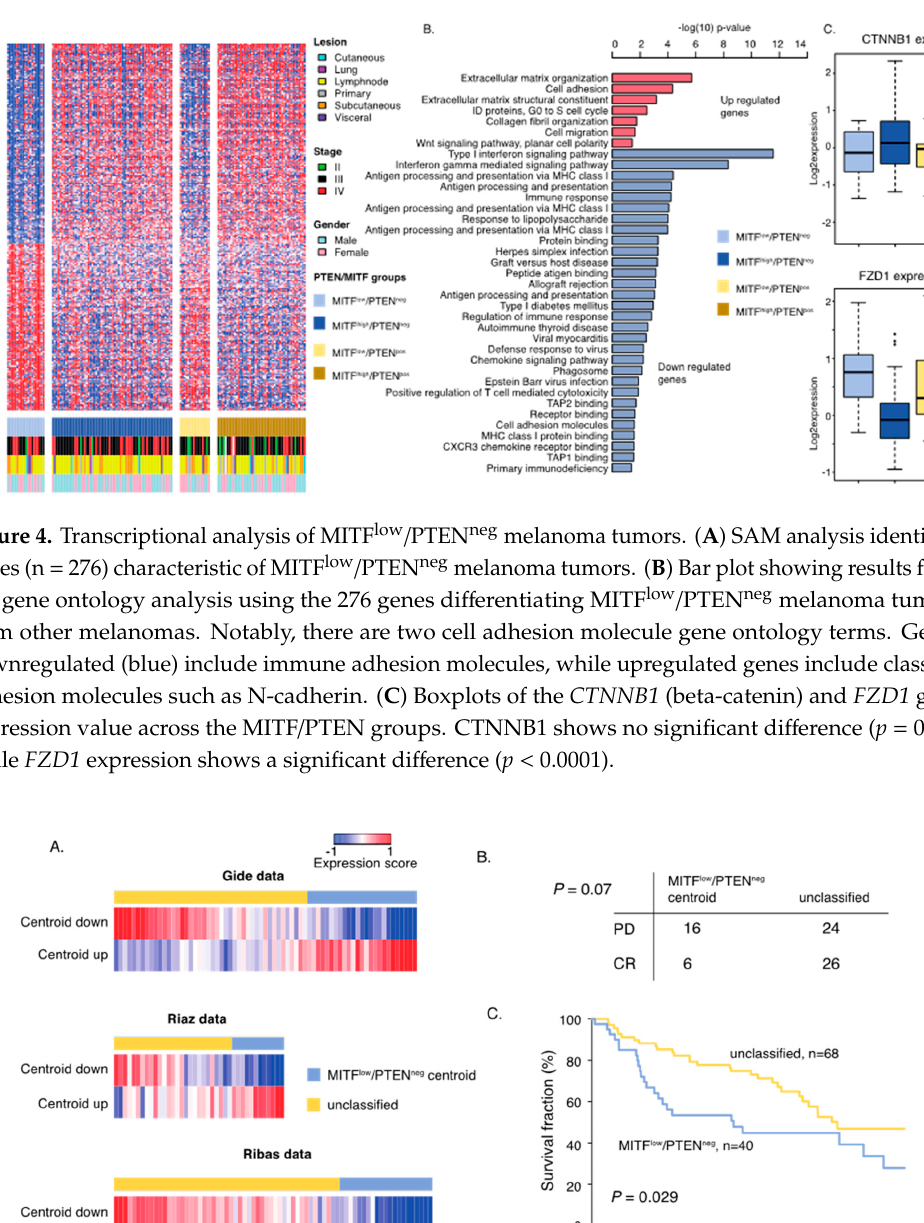
Figure 3. Molecular characterization of MITF/PTEN groups. ( A ) Mutational pattern of representative genes of the MAPK and PI3K pathways in MITF/PTEN groups. In MITF low /PTEN neg , two harbored PTEN mutation, three cases had PIK3CA mutation, and one had PIK3R1 mutation. In the MITF high /PTEN neg group, ten had PTEN mutation and one had PIK3CA mutation. The two other group had one PTEN mutated case each. ( B ) Mutational load across MITF/PTEN grouping using the number of mutations across 1500 cancer genes. p > 0.5, Kruskal–Wallis analysis. ( C ) Kaplan–Meier survival analysis using log-rank tests of MITF and PTEN markers combined. Survival data were missing for two cases in both MITF low /PTEN neg and MITF high /PTEN neg groups and five cases in the MITF high /PTEN pos group.